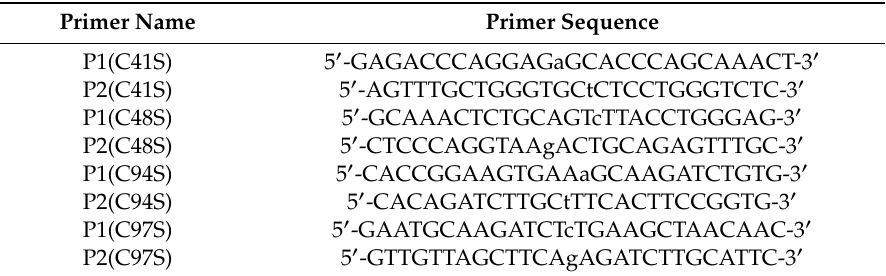
Table 3. PCR primers for chIL-2 gene